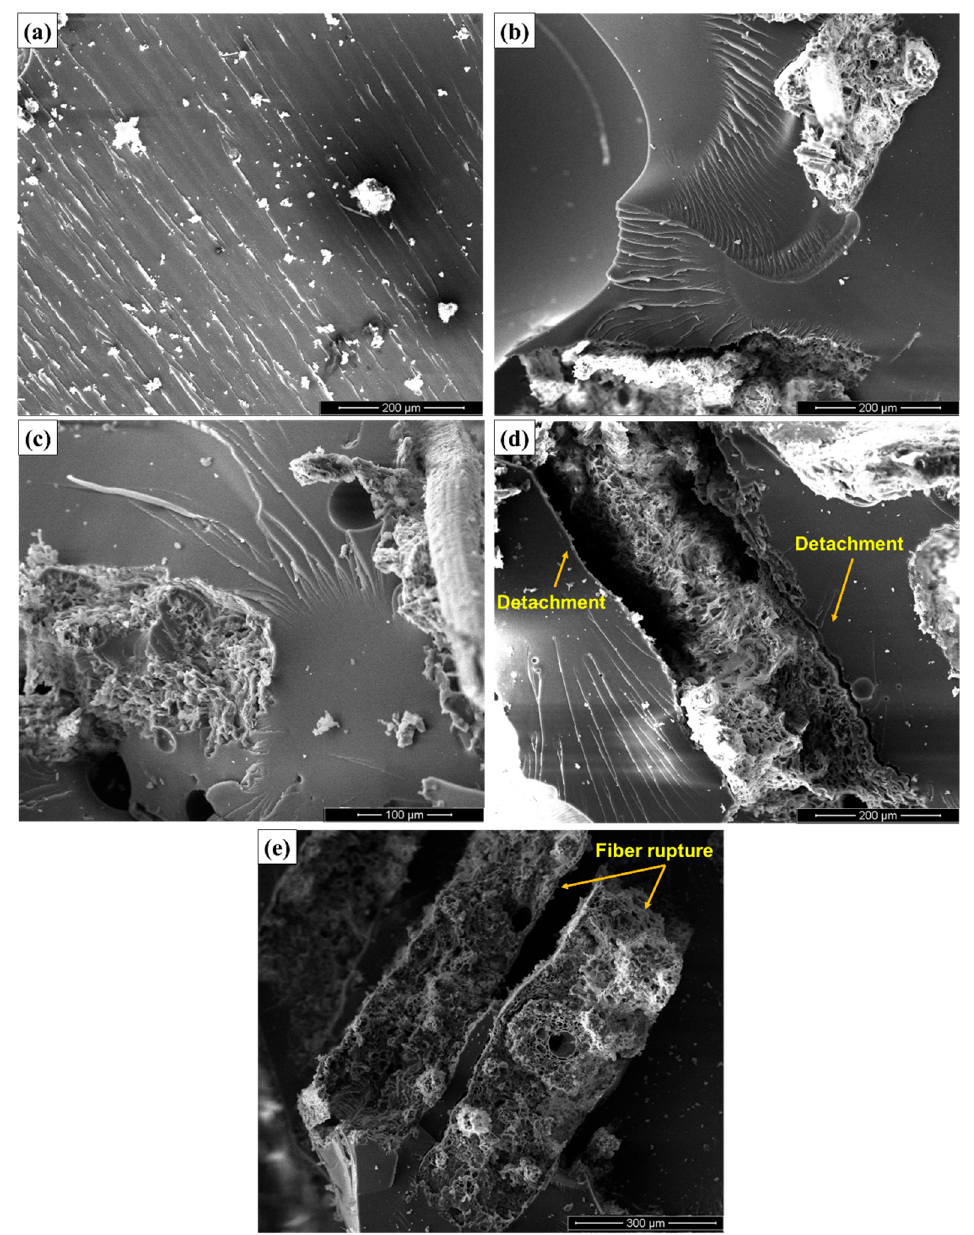
Figure 11. Scanning electron microscopy of fracture surfaces of composites reinforced with carnauba fibers after Izod impact tests. ( a ) 0 vol% 400 × ; ( b ) 10 vol% 400 × ; ( c ) 20 vol% 600 × ; ( d ) 30 vol% 400 × ; and ( e ) 40 vol% 300 × of fibers.